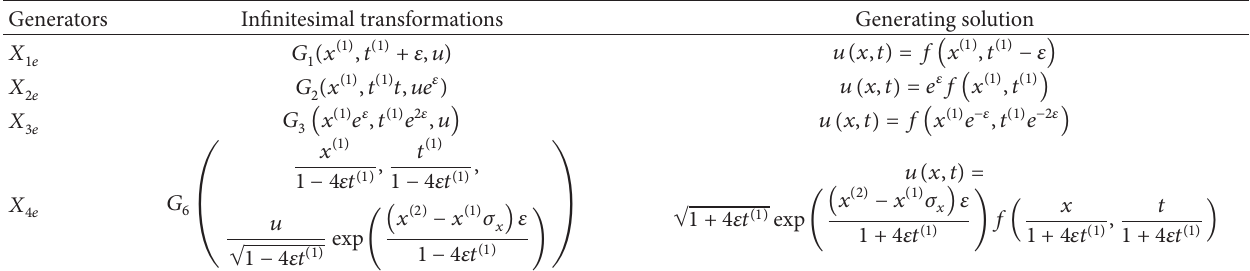
Table 6: Generating solutions for discrete centrifugal